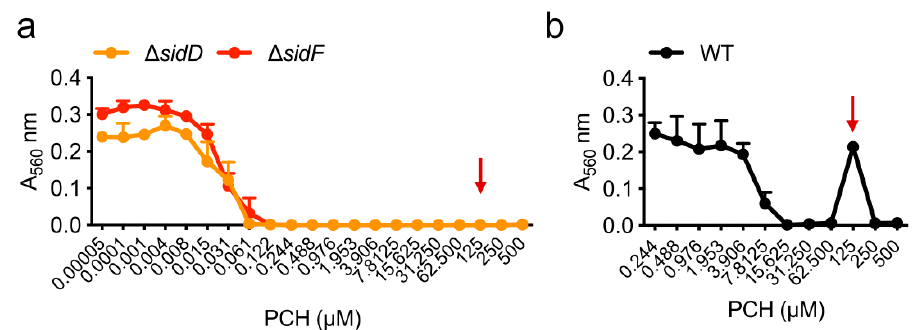
Figure 3. A. fumigatus growth stimulation (arrow) by pyochelin (PCH) sub-inhibitory concentrations. Effect of pyochelin on Δ sidD and Δ sidF in MM ( a ) and on WT in MM(-Fe) ( b ). Note the absence of pyochelin stimulation in the TAFC siderophore minus mutant’s Δ sidD and Δ sidF , showing the essentiality of the presence of TAFC. Medium composition and methodology are described in Supplementary Materials.